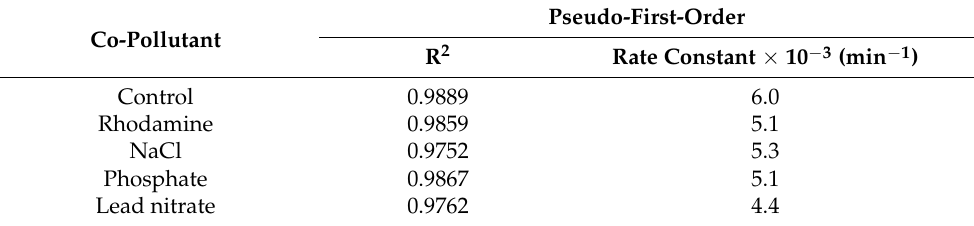
Table 6. Pseudo-first-order rate constants showing the effect of co-pollutants on the photocatalytic activity.